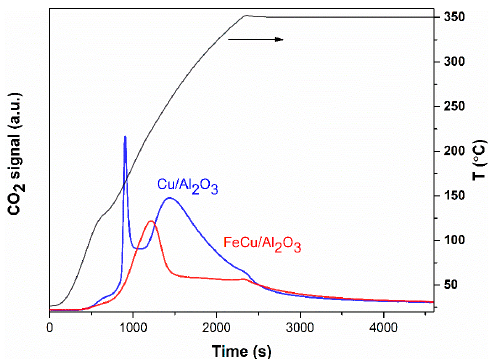
Figure 6. CO-TPR profile of the Cu/Al 2 O 3 and FeCu/Al 2 O 3 catalyst. Reaction conditions: W cat = 0.3 g, F CO/Ar = 100 mL/min, ramping rate: 10 °C/min.